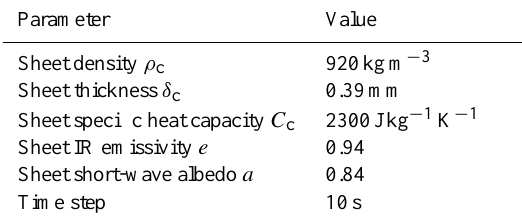
Table 1. Some parameters used in the model, unless specified oth- erwise. The properties of the foil are for common low-density polyethylene with composition according to Nilsson et al. (1994) and radiative properties as found by Clus